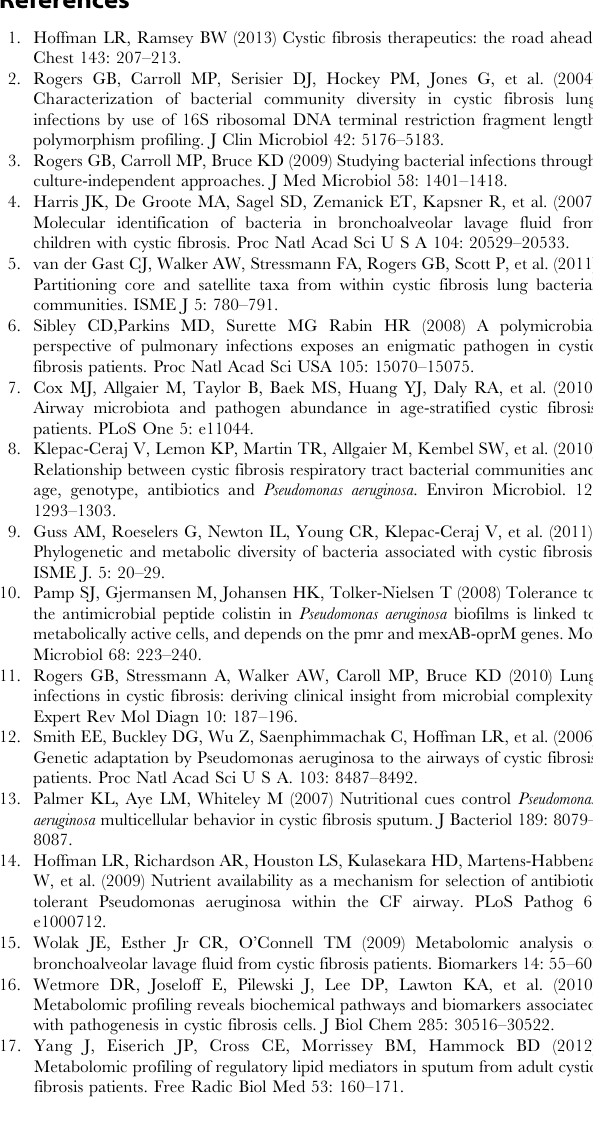
Table S5 Concentrations of metabolites identified in CF sputum taken from 26 CF patients presenting with exacerbation. Data are given as the average values measured in triplicate (metabolite concentrations are described as m M unless otherwise stated and means 6 standard deviations are